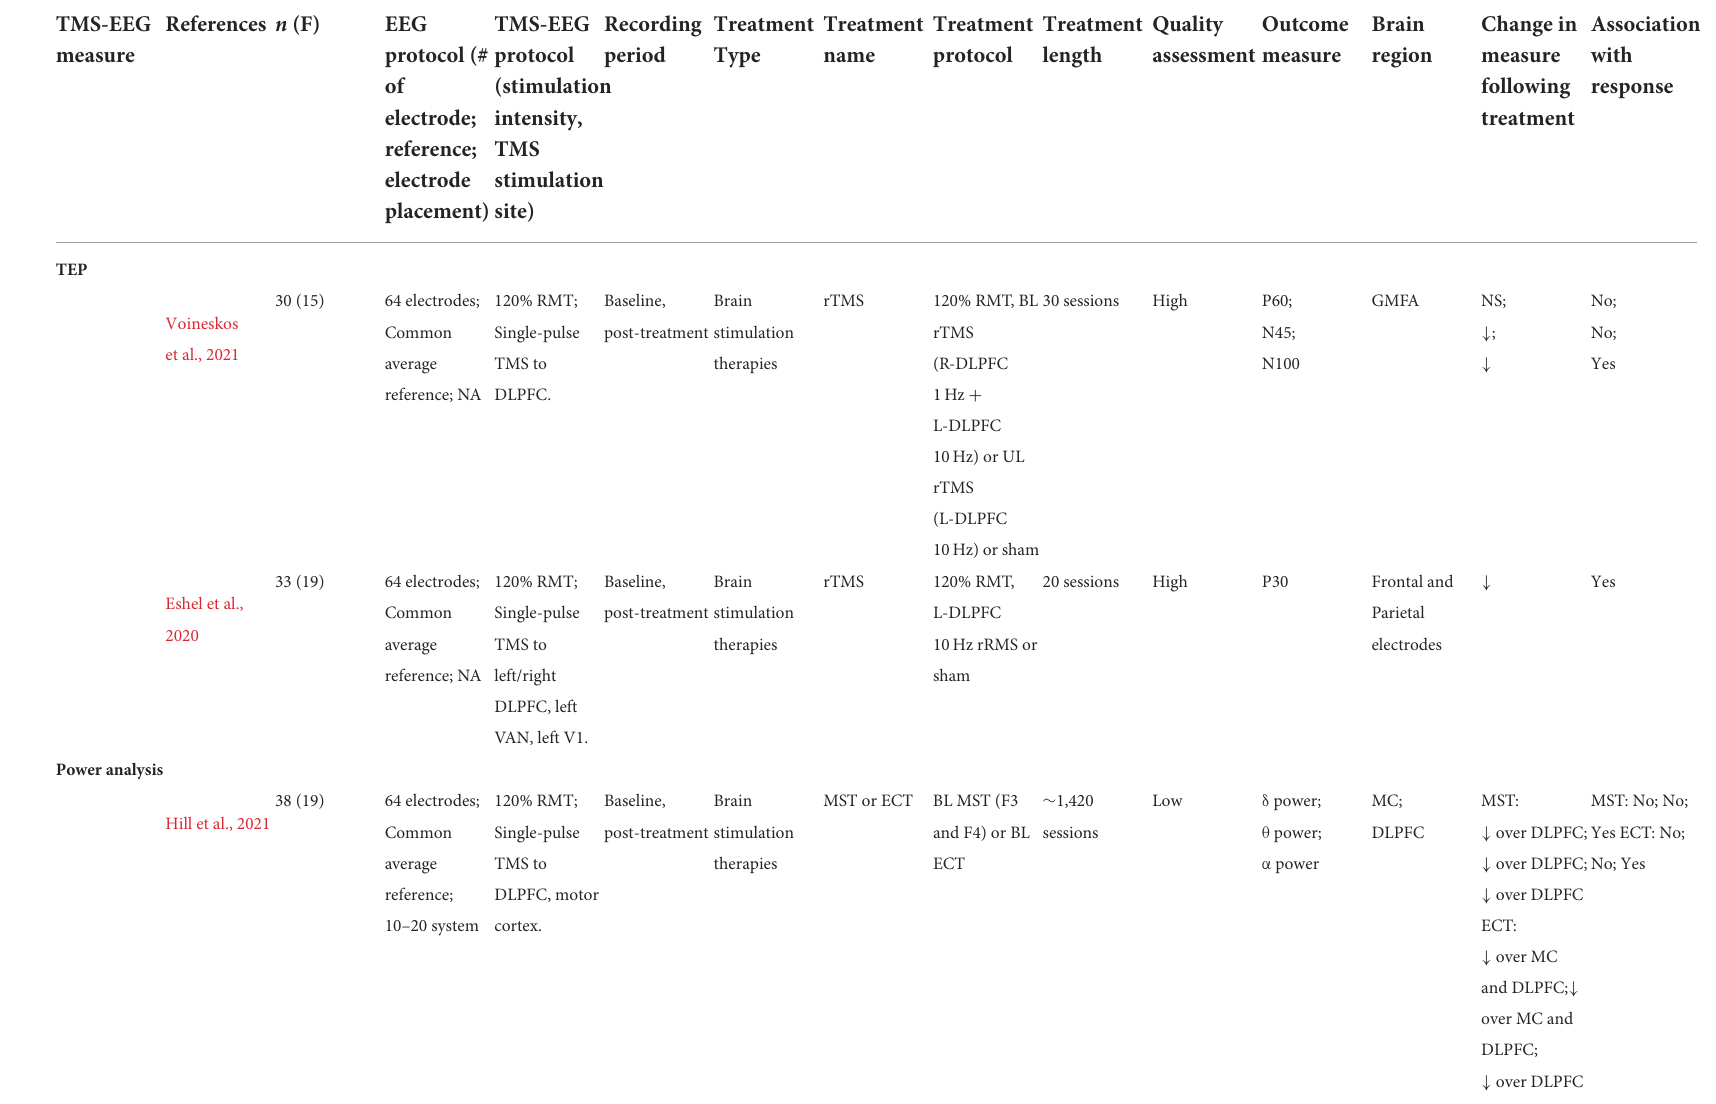
TABLE 2 TMS-EEG outcomes for brain stimulation